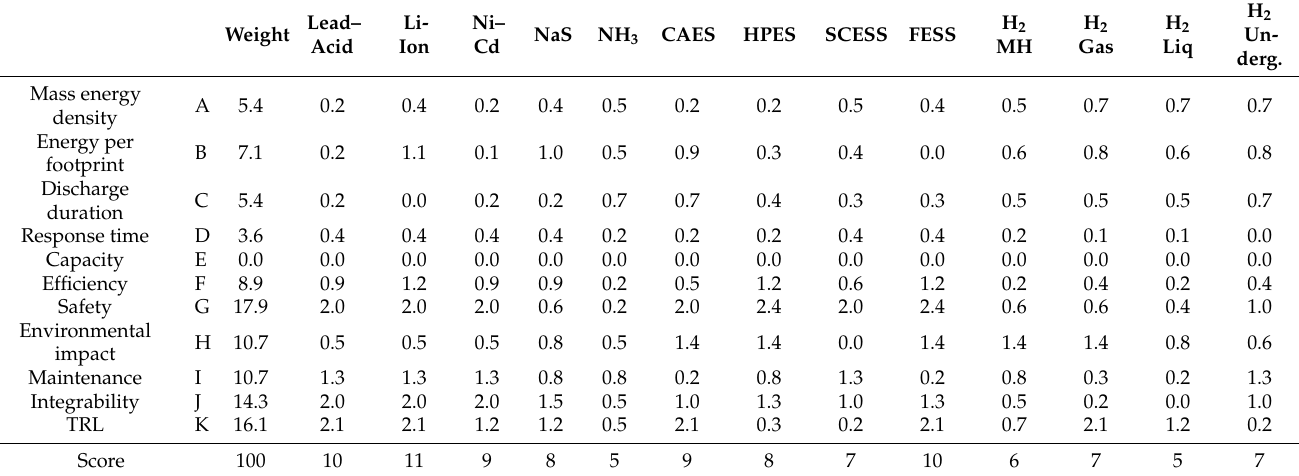
Table A6. General matrix of technology comparison for Scenario A.